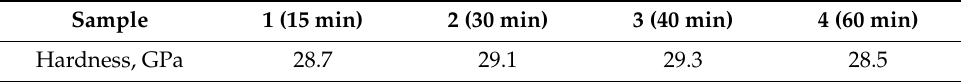
Table 2. Microhardness values of the coated samples under study.